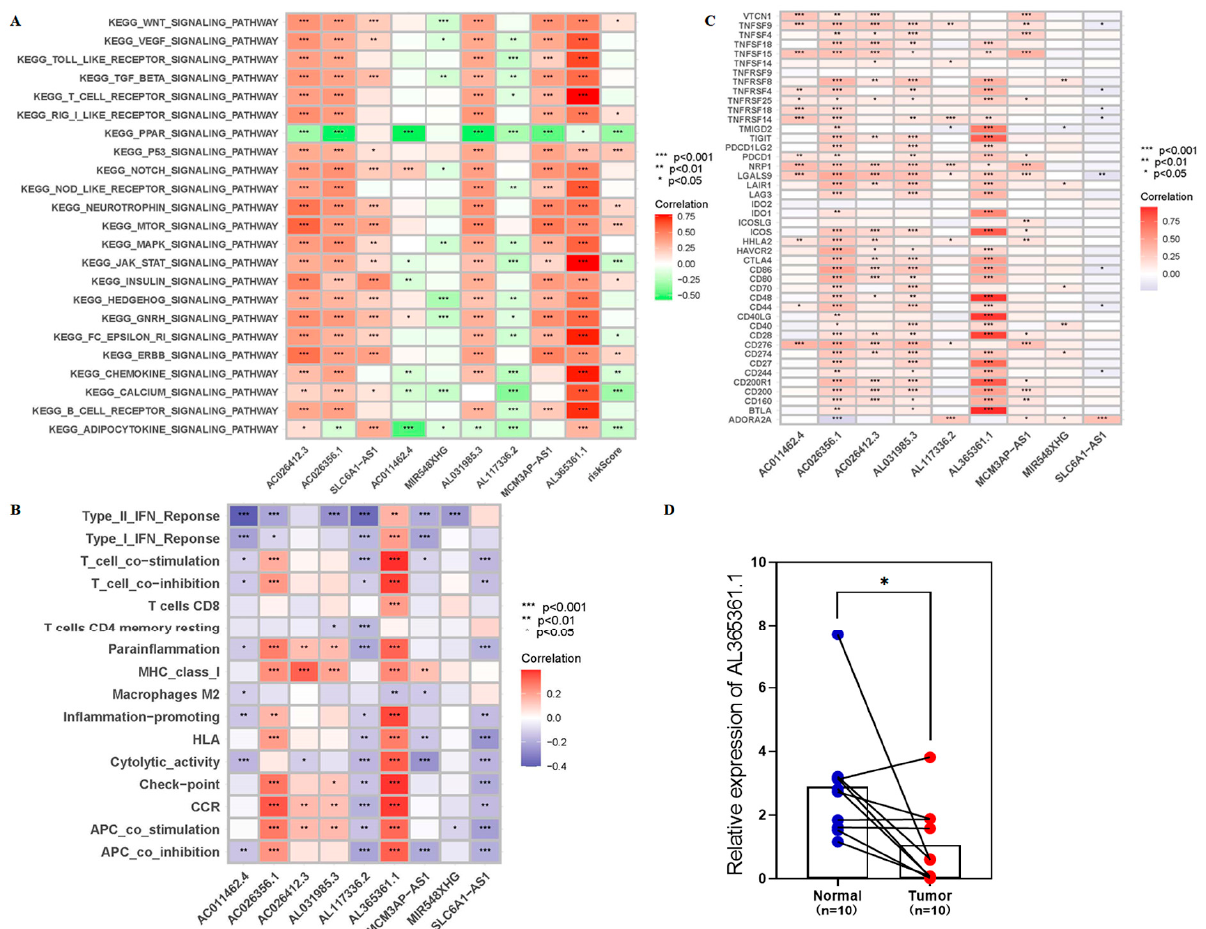
Figure 9. The connection between 9-crLncrNA prognostic signature and the immune landscape. ( A ) Correlation heatmap of KEGG pathways by GSVA. ( B ) The 9-crLncrNA correlates with 22 immune cells and immune-related functions on a heatmap. ( C ) The heatmap of the correlation between the 9-crLncrNA and immune checkpoint genes. ( D ) The differential analysis plots show the expression of AL365361.1 in HCC tissue and adjacent normal tissue from HCC patients. * p < 0.05, ** p < 0.01, and *** p < 0.001.